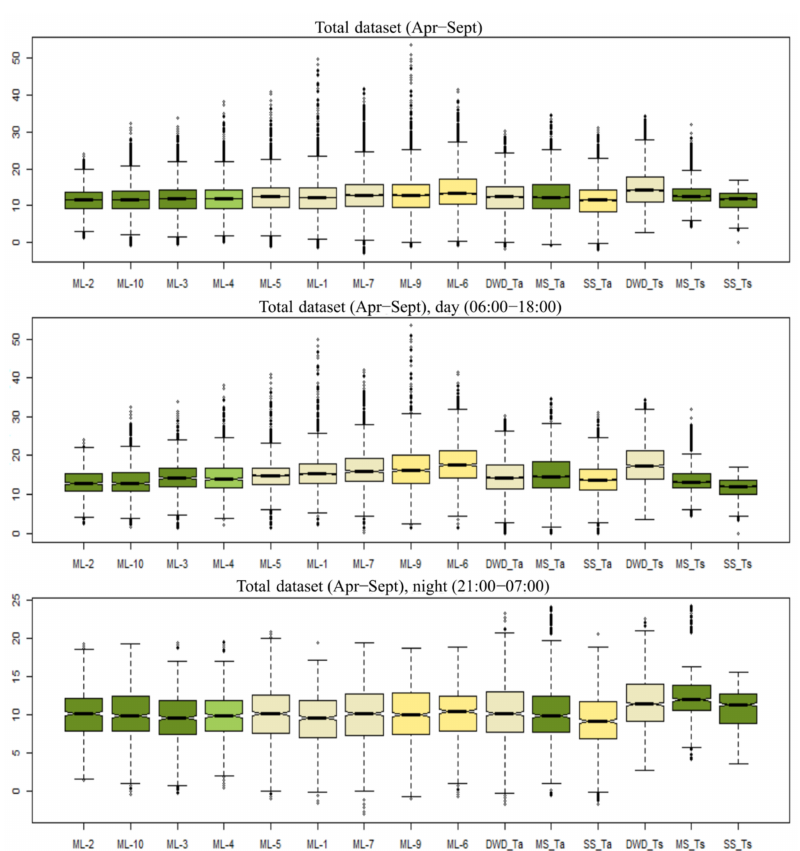
Figure A1. Overview of the data distribution of all Micro-Loggers (ML1 to 10), the air and soil temperature of the Medium and Small Stations and the official weather station (DWD). The colors imply the grade of shading of the loggers and stations (dark green = very shaded/moss, yellow = open land/grass, beige = temporal shading/grass (ML-9 = moss), light green = temporal shading/leaf litter). The graph shows the data distribution of the total timespan (top), only at daytime (middle) and only nighttime (bottom). The ordinate depicts the temperature ( ◦ C), please note the different